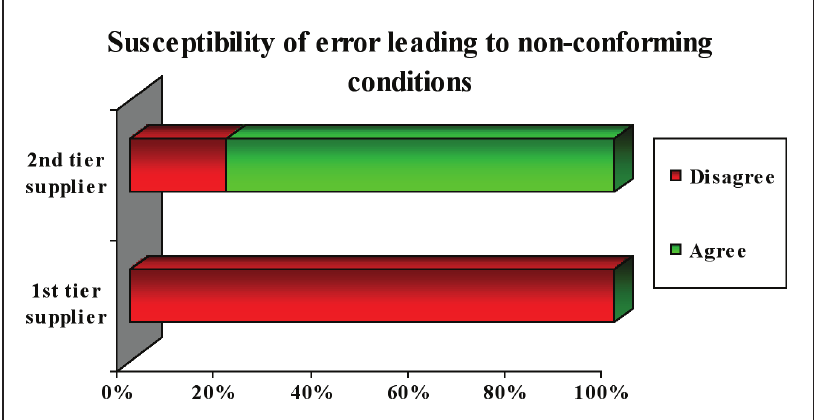
Figure 6: 100% stack bar for first and second tier